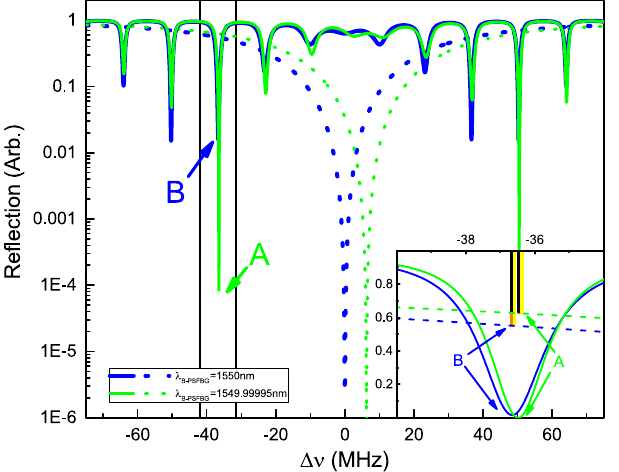
Figure 3. Theoretical spectrum reflection of 7.3 m long PSFBG-FPI-FBG resonator, plotted versus the frequency detuning Δ v = C / λ − C / λ B . The blue solid line and blue dot line are the reflection spectrum of PSFBG-F-FBG resonator and single PSFBG with a Bragg wavelength of 1550 nm, respectively. The green solid line and green dot line are the reflection spectrum of PSFBG-F-FBG resonator and single PSFBG with a Bragg wavelength of 1549.99995 nm, respectively. Inset: Detail description of impedance matching situation of points A and B.